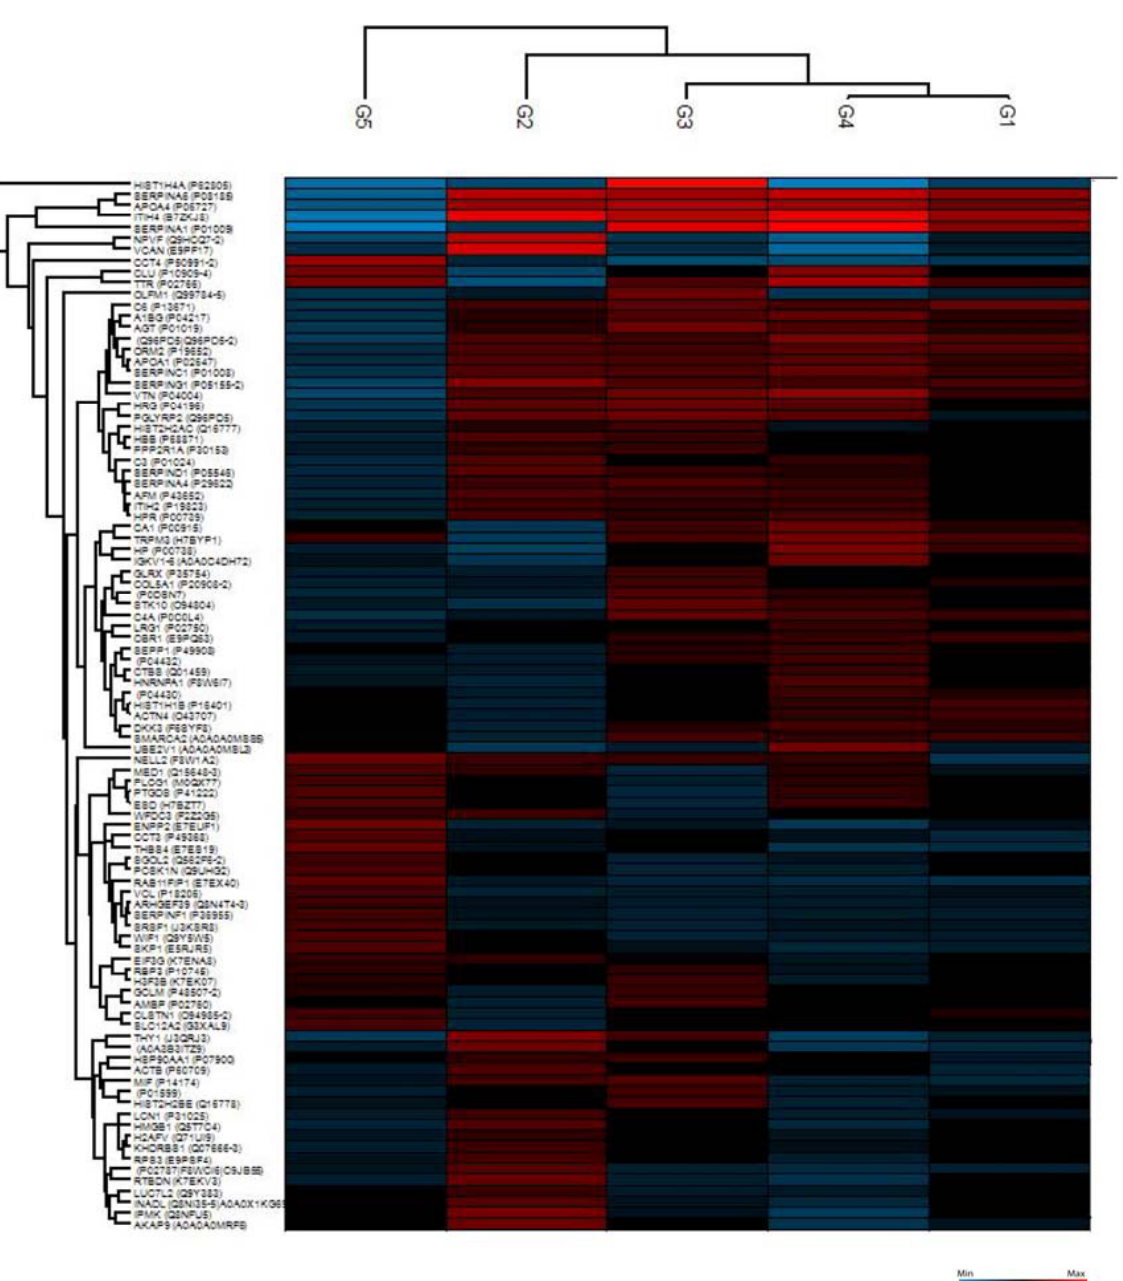
Figure 1. Unsupervised hierarchical-clustered heatmap of proteins identified by ANOVA testing. Heatmap showing the distinctive proteomic signature of the 5 different groups: Group 1 (active vitreous seeding), Group 2 (active aqueous seeding), Group 3 (naïve RB), Group 4 (inactive RB), and Group 5 (congenital cataracts). The amount of each protein in the different groups is represented by the color scheme, in which red and blue indicate high and low proteins expression, respectively. The top 10 significantly most upregulated proteins in Group 5 were: thrombospondin type-1 domain-containing protein 7A (THSD7A); T-complex protein 1 subunit delta (CCT4); serine/arginine-rich-splicing factor 1 (SRSF1); centrosomal protein 295 kDa (CEP295); cilia- and flagella-associated protein 91 (MAATS1); immunoglobulin lambda variable 3–12 (IGLV3-12); TATA element modulatory factor (TMF1); and disintegrin and metallopro- teinase with thrombospondin motifs 1 (ADAM-TS 1); peroxiredoxin-4 (PRDX4);